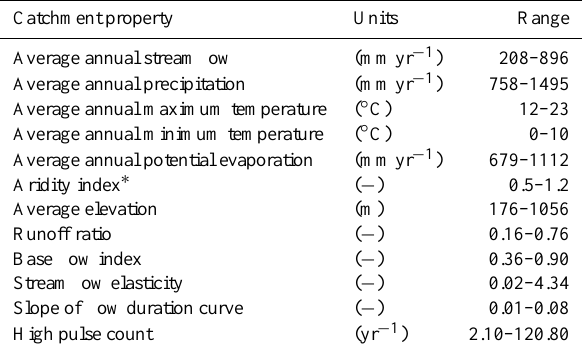
Table 1. Summary of general catchment properties and response signatures of the 84 MOPEX